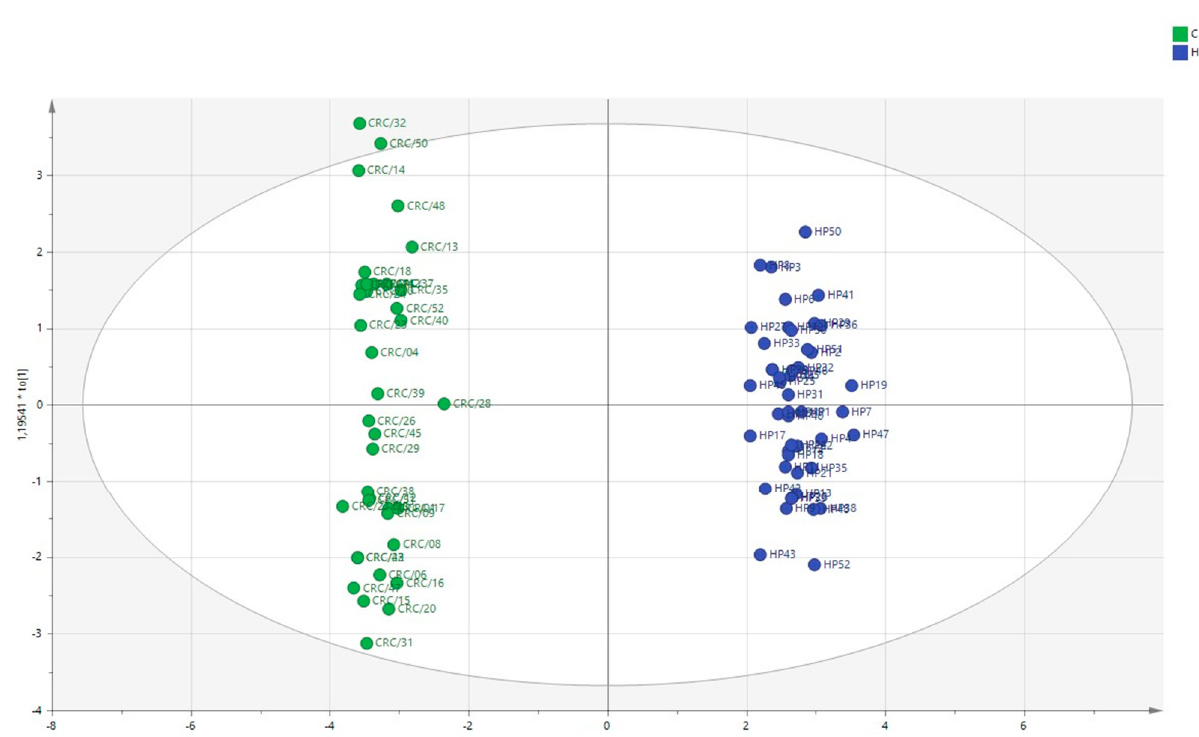
Figure 1. Multivariate analysis using PLS-DA method. Colorectal carcinoma group (green); healthy subject group (blue).